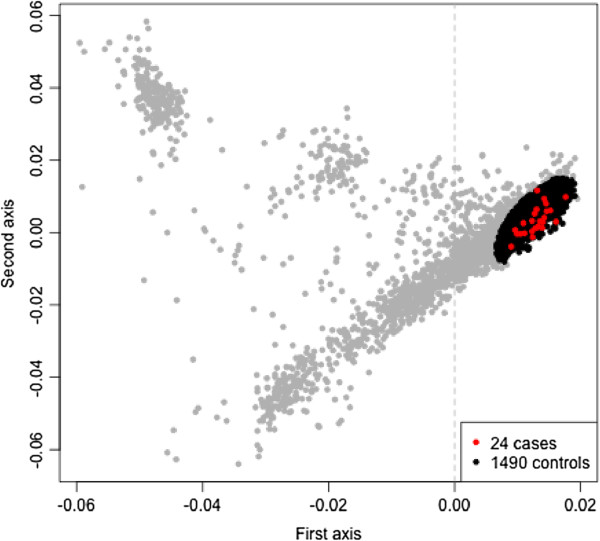
Principal Component Analysis for selection of iControlDB individuals. The first and second principal components The 24 breast cancer cases from the three pedigrees are shown in red, and the selected iControlDB individuals are shown in black.